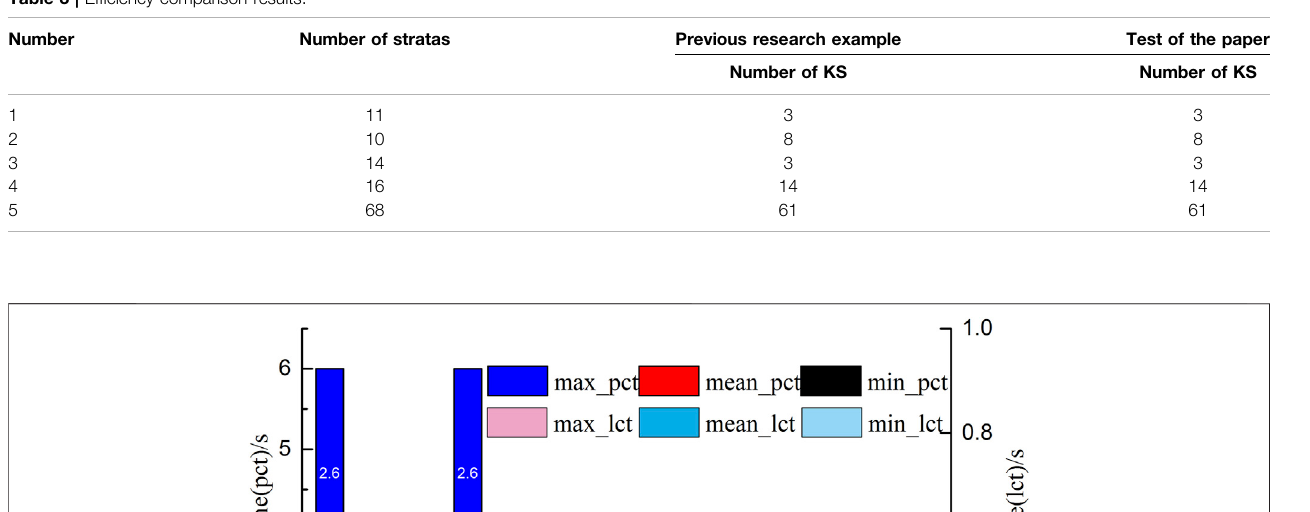
Table 3 | Ef fi ciency comparison results.